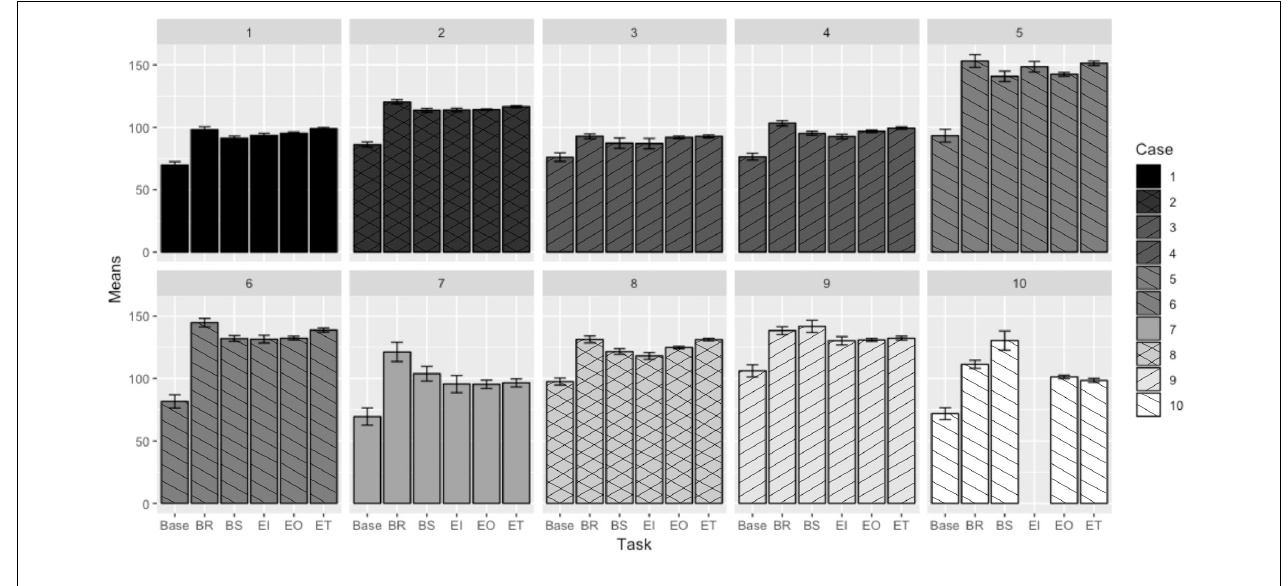
FIGURE 1 | Mean heart rate responses to EVA-like tasks (Hill, 2019). TABLE 5 | Differences in heart rate responses to EVA-like tasks (Hill,